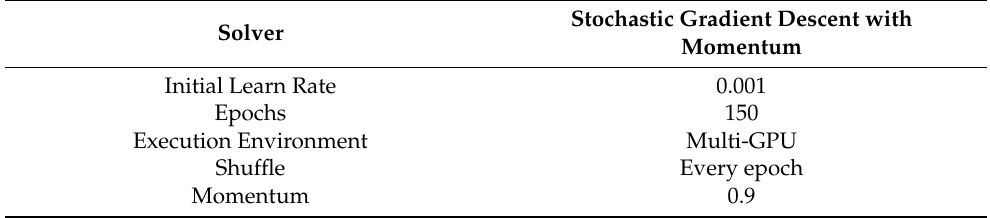
Table 3. Training options. Stochastic Gradient Descent with Solver Momentum Initial Learn Rate 0.001 Epochs 150 Execution Environment